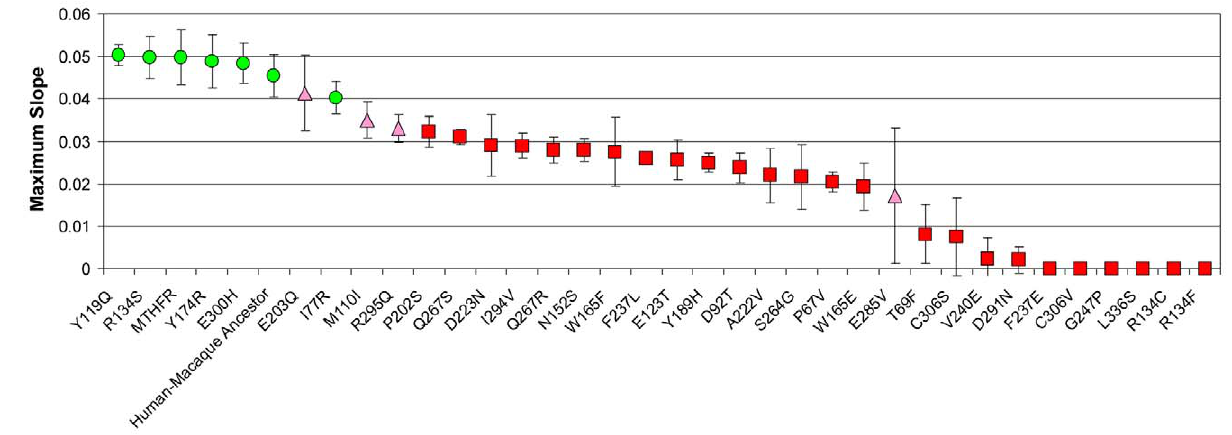
Figure 2. Activities of MTHR mutants. The average maximum slope (growth-rate metric) and standard deviation for each of the 36 MTHFR variants tested as in Methods. Replicate sets (N=5) were compared against a positive control (major MTHFR allele) and a negative control (A222V allele) using 2 different statistical criteria as described in Methods. Green circles indicate changes not significantly different from the positive control and significantly better than the A222V control and indicate functionality. Red squares indicate changes significantly less active than the positive control and not significantly better than the A222V control and indicate impaired alleles. Pink triangles are classified as equivocal due to disagreement in the statistical methods. The raw replicate data and statistical metrics are in Table